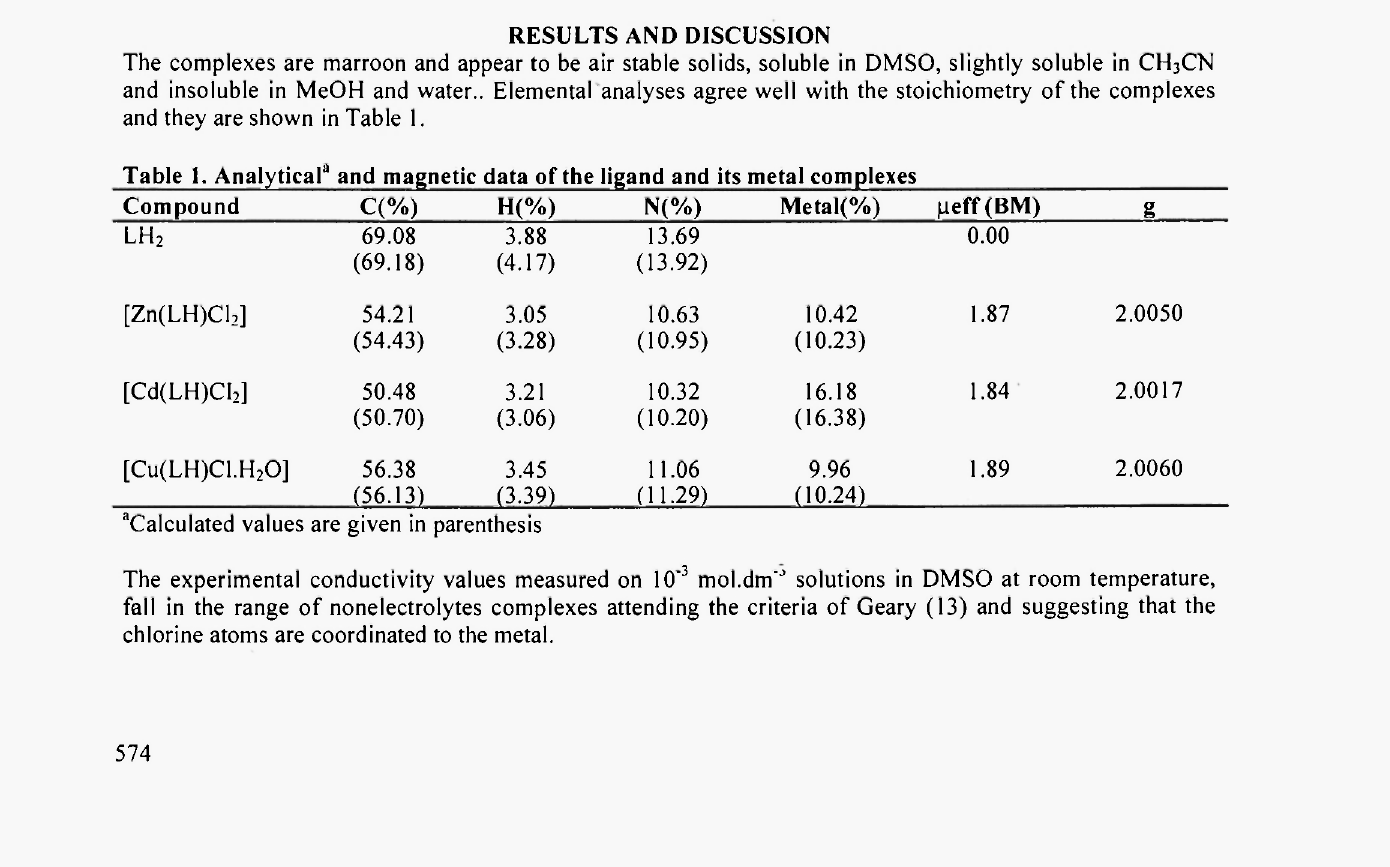
Table 1. Analytical" and magnetic data of the ligand and its metal